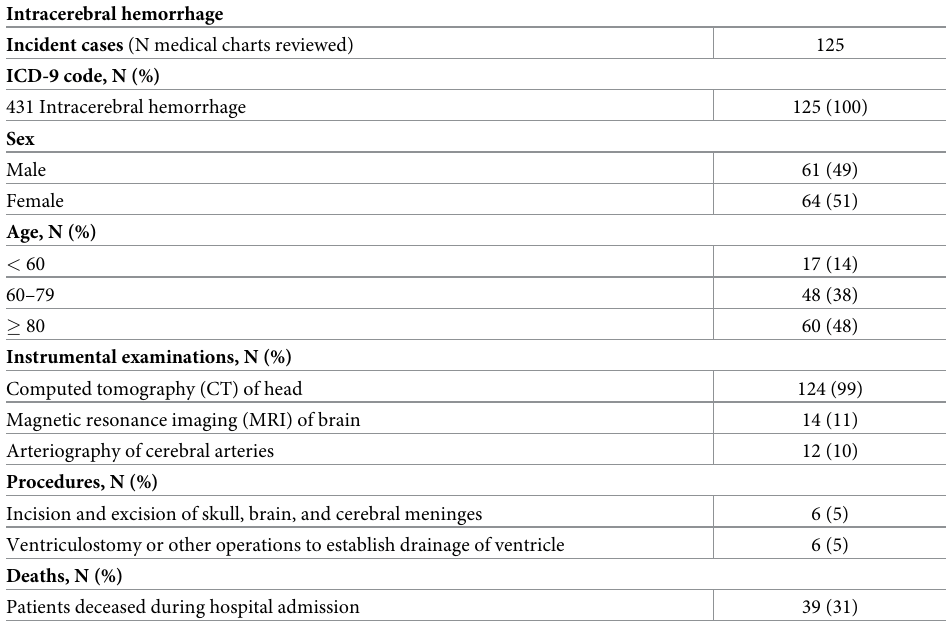
Table 3. Characteristics of patients with intracerebral hemorrhage who were identified in the Regional Adminis- trative Database of Umbria. Intracerebral hemorrhage